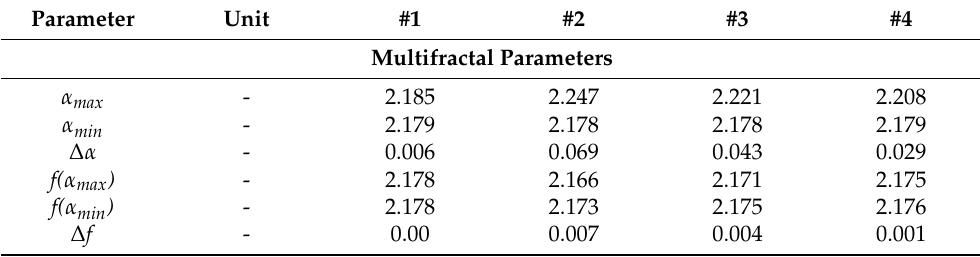
Table 4. Sample multifractal